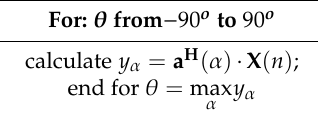
Table 1. Direction of arrival (DOA) estimation method.